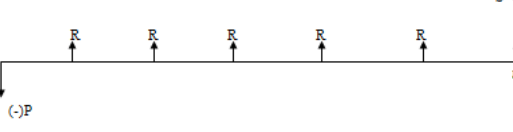
Fig. 2. Revenue - Dominated Cash Flow